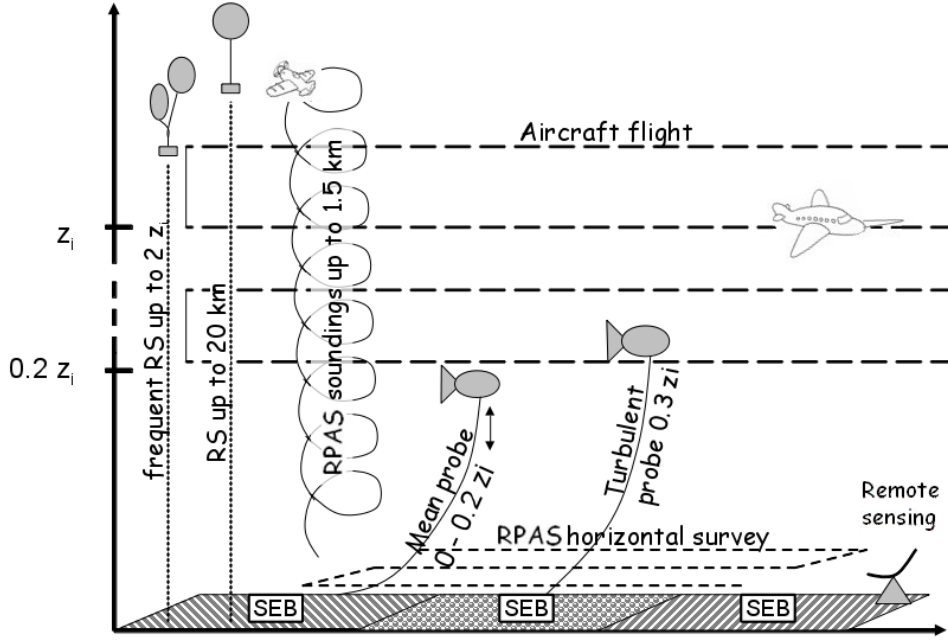
Figure 4. Illustration of the observing strategy during the IOPs. RS = radiosounding, RPAS = remotely piloted aircraft system, SEB = surface energy balance. Aircraft = Sky Arrow and Piper